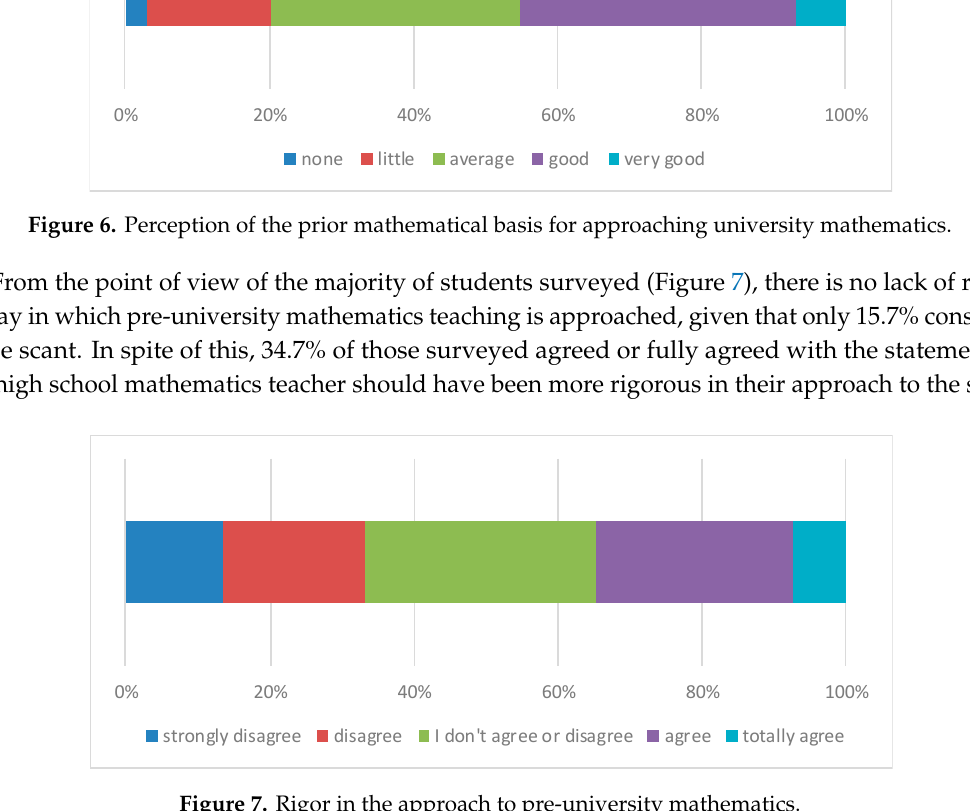
Figure 7. Rigor in the approach to pre-university mathematics.